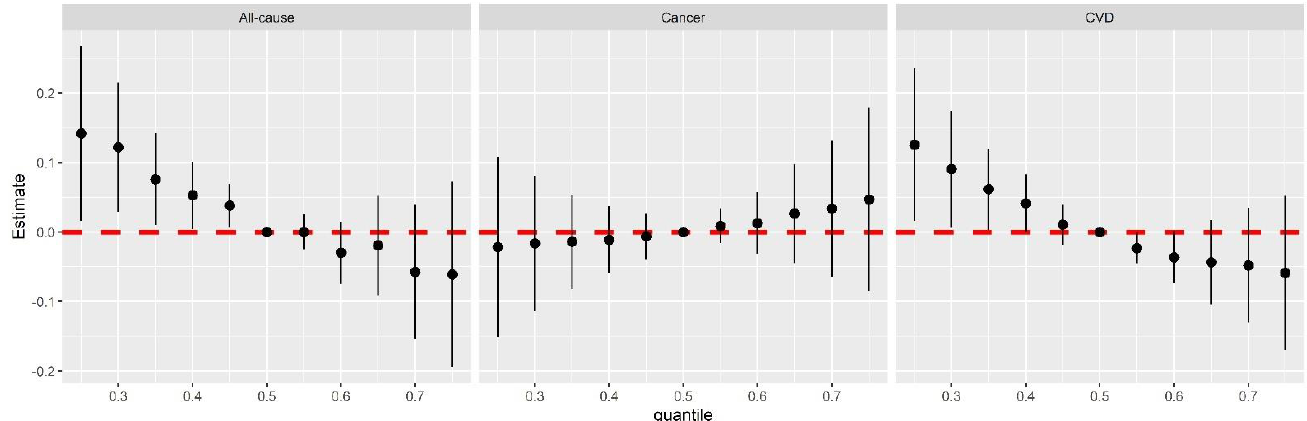
Figure 1. The estimated associations of all biomarker mixtures with all-cause, cancer, and CVD mortality risk with 95% confidence intervals. The X − axis shows percentiles of biomarkers mixtures. The Y − axis shows the estimated change in risk of all − cause mortality. The lines of the plot show the overall effects of the mixture (estimates and 95% CIs) in mortality risk when biomarkers are all at a particular percentile compared to when biomarker are s set at the 50th percentile.